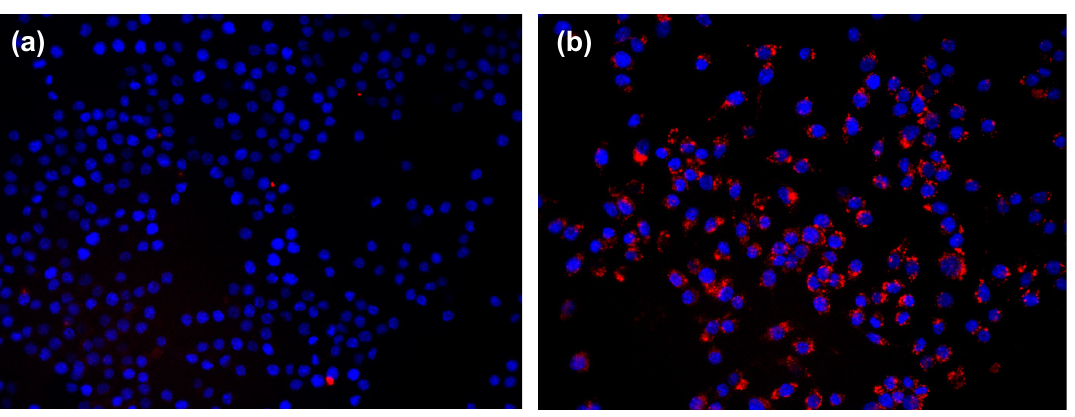
Figure 8. Fluorescence microscopy images of RAW 264.7 cells incubated with ( a ) γFe 2 O 3 @PolyR/Li28/Arg 15 and ( b ) γFe 2 O 3 @Li28_Arg 15 nanocomplexes. Nuclei are stained in blue with DAPI. Internalization of NPs, labeled with TAMRA, is seen in the cytoplasm (red dots). ×400